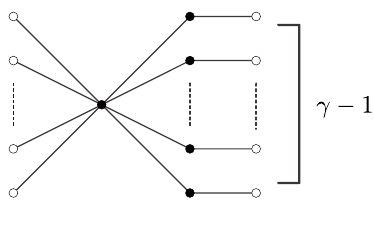
Figure 1: The graph T n,γ